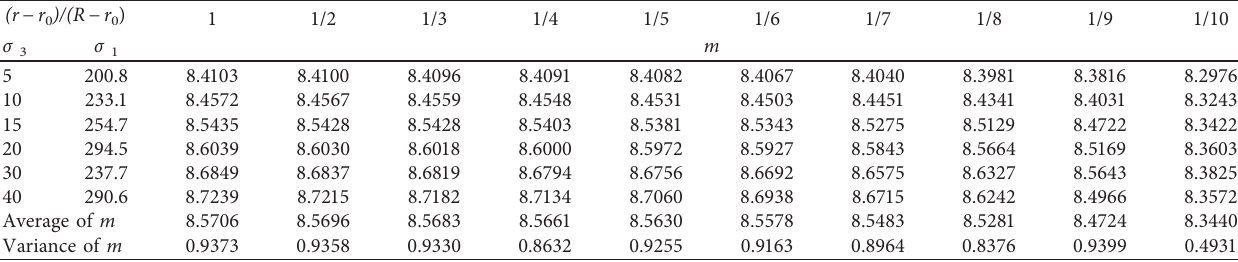
Table 4: The value of m in the specimen with an aperture of